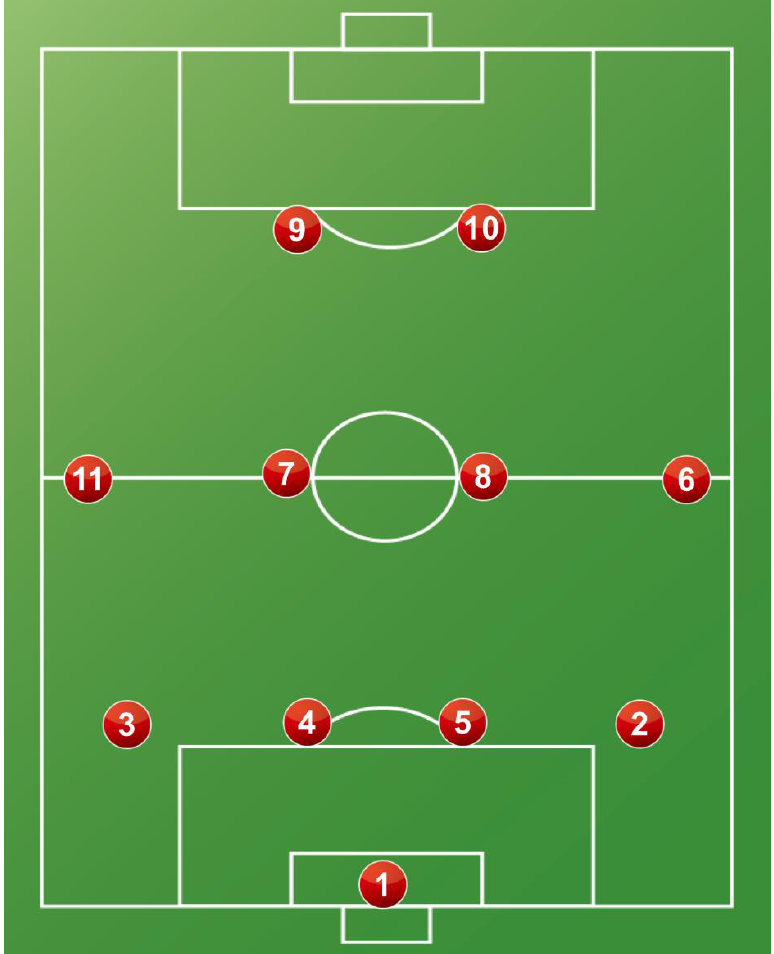
Figure 1.1 – A football team with a 4-4-2